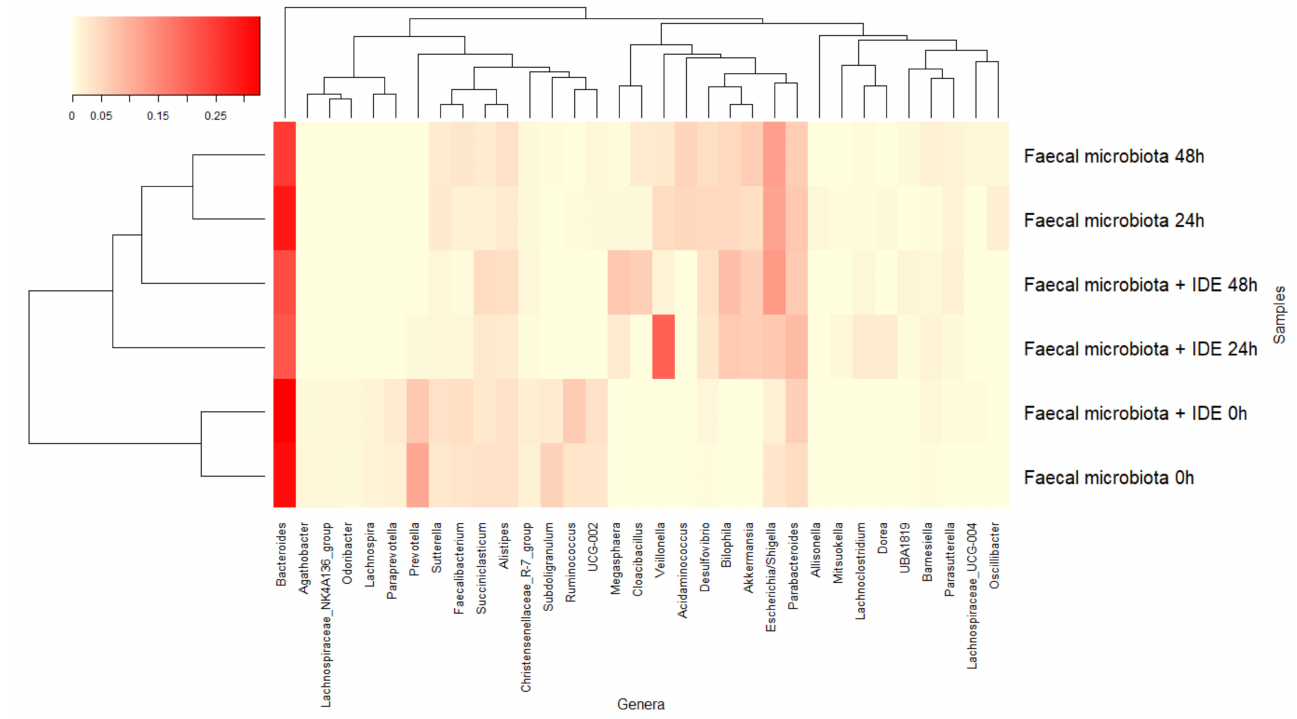
Figure 5. The evolution of bacterial genera with relative abundance higher than 1% during faecal fermentations in the absence and presence of intestinal-digested extract